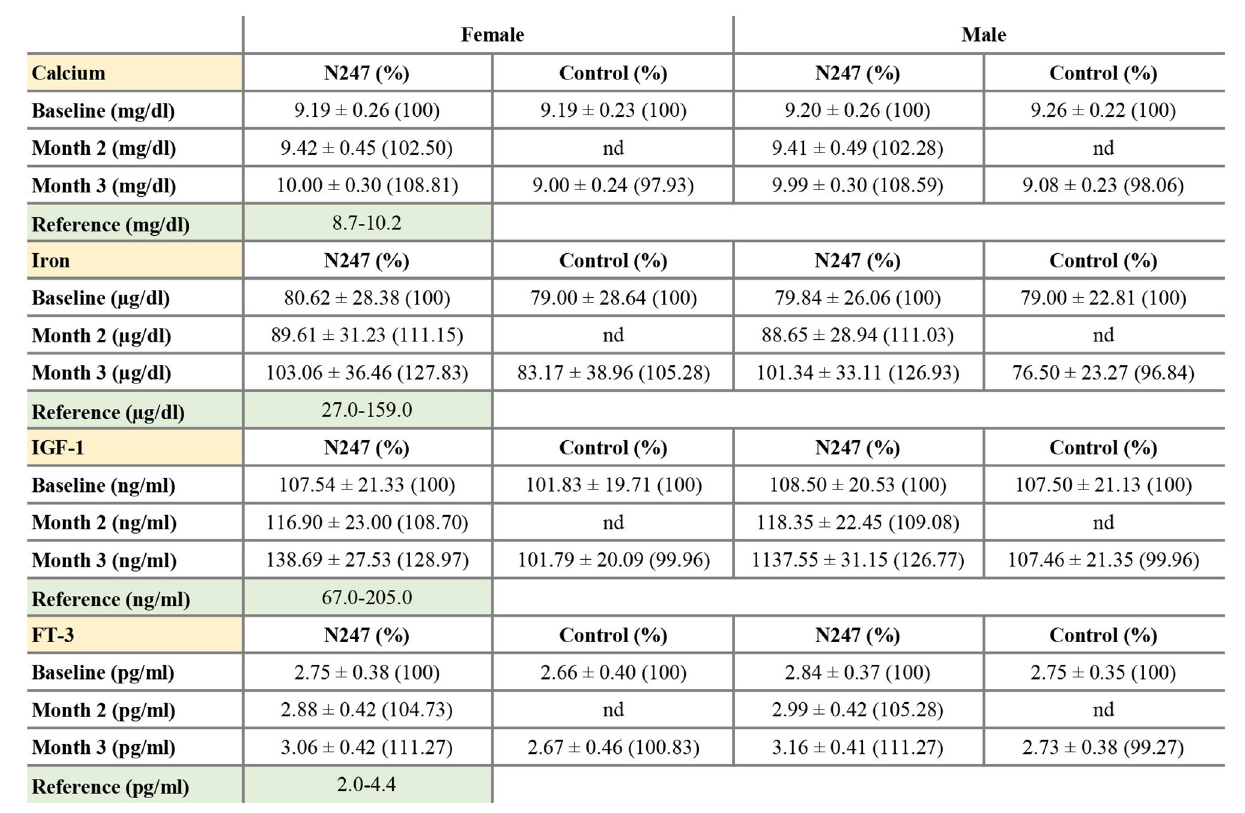
SD% values are given in parentheses. ±